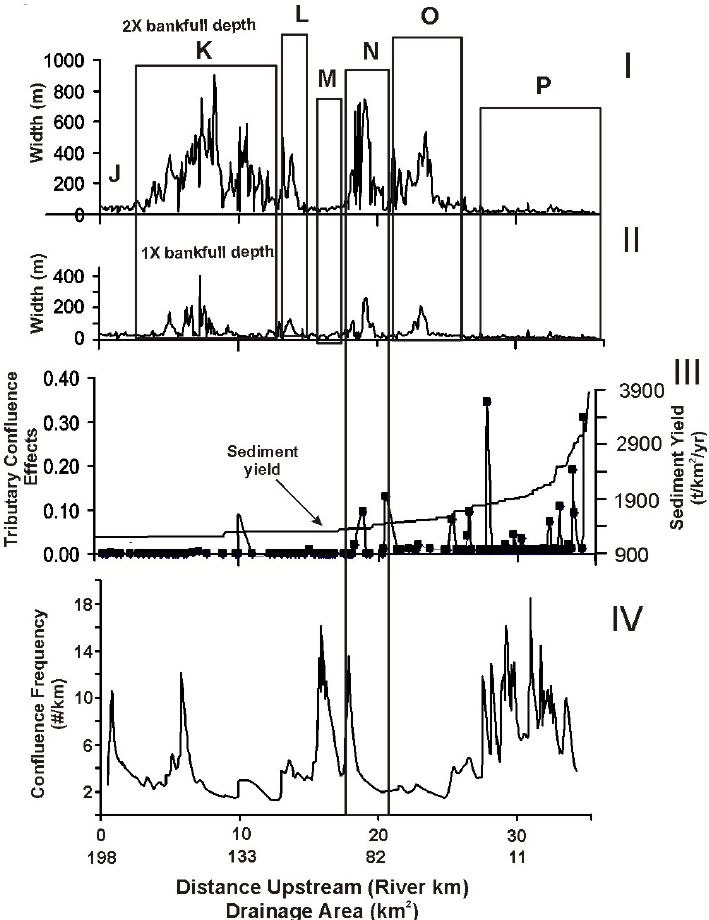
Fig. 8. The predicted fluvial landscape in the East Fork of the Pas River at an elevation above the channel equivalent to one and two bankfull depths is highly variable (I, II) . The predicted tributary confluence effects and average sediment yields (using a catchment wide average of 1000tkm − 2 yr − 1 ) are shown in (III) . The spatial frequency of tributary intersections along the East Fork reveals a clumped pattern (IV) . Site locations J–P are mapped in Fig.